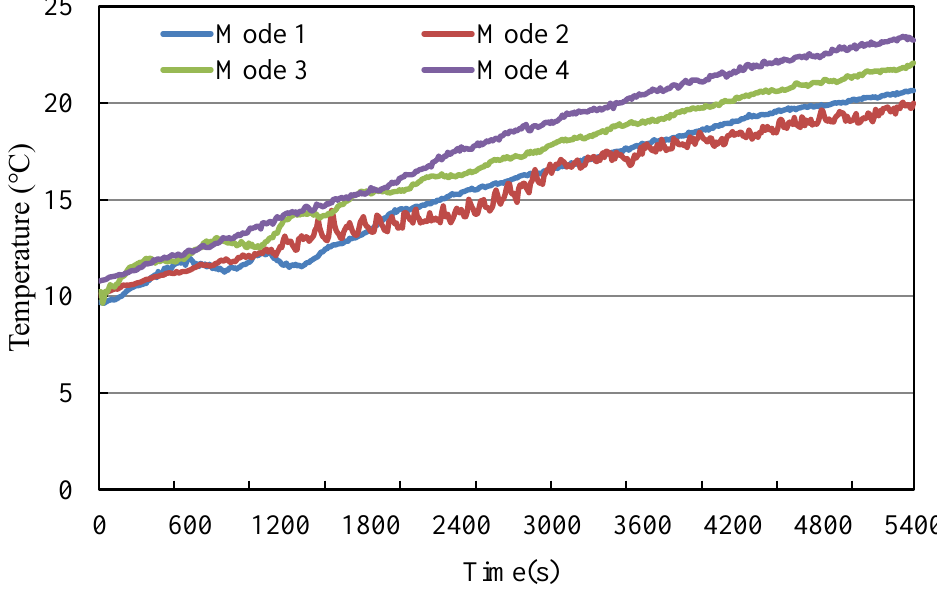
Figure 8. Air temperature (50 cm from floor surface).